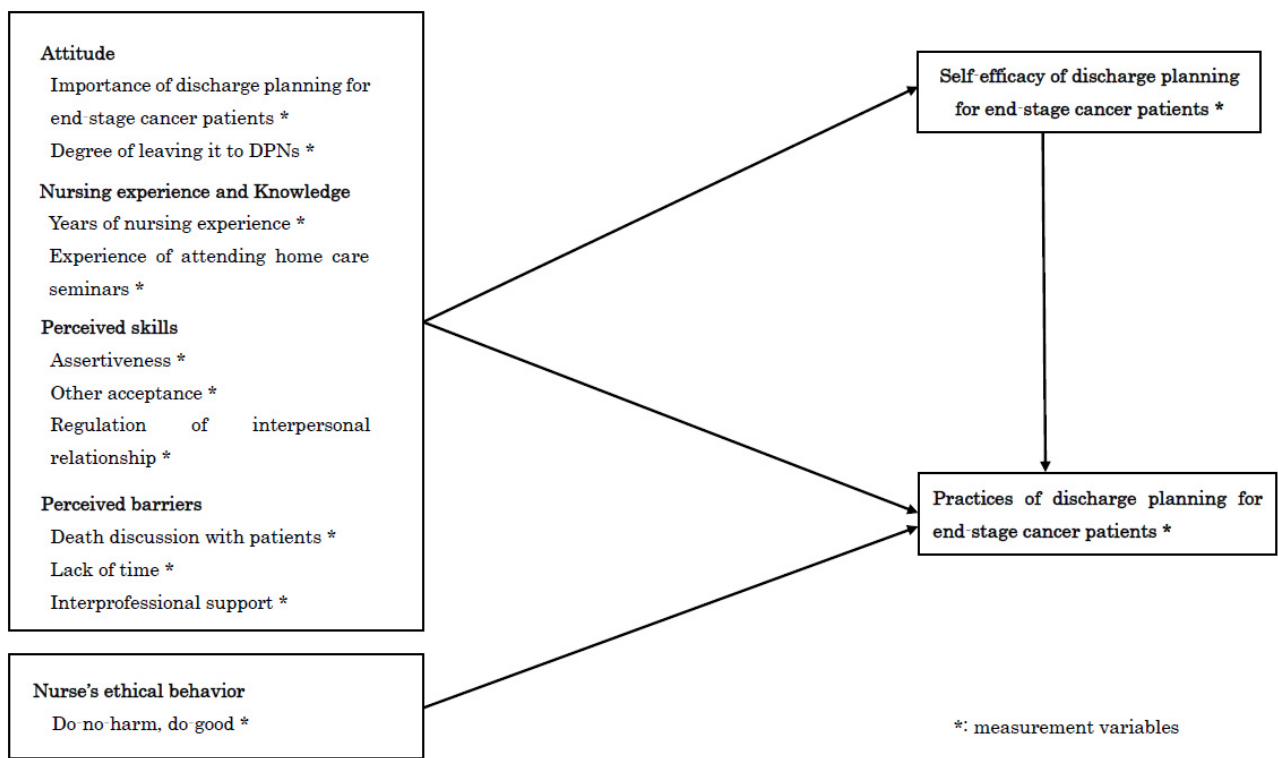
Figure 1. The hypothesized model.